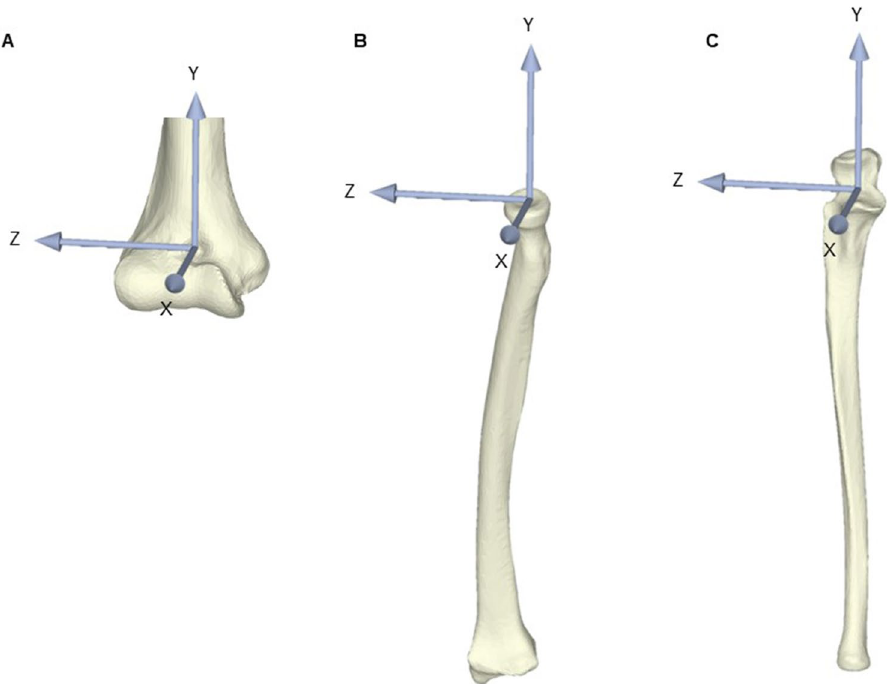
Figure 5. Coordinate system for the direction of translation of the joint contact area centroid. ( A ) The anatomical coordinate systems of the humerus, ( B ) radius, and ( C ) ulna. Rotation around the X-axis, Y-axis, and Z-axis is indicated as varus (+)/valgus (−), internal rotation (+)/external rotation (−), and flexion (+)/extension (−), respectively. Translation along the X-axis, Y-axis, and Z-axis is indicated as the anterior (+)/posterior (−) direction, proximal (+)/distal (−) direction, and lateral (+)/medial (−) direction,